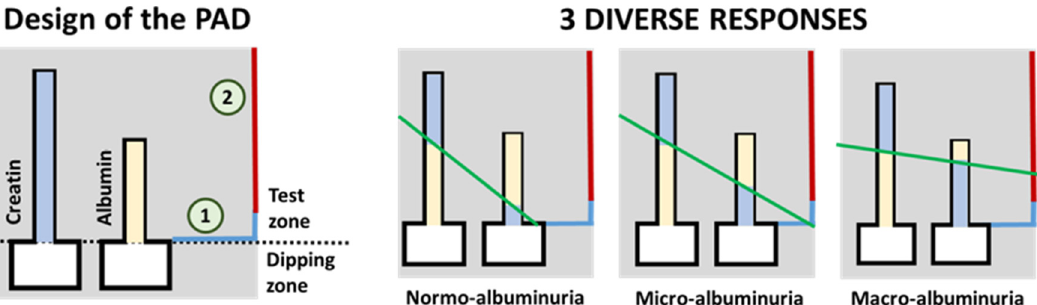
Figure 3. On the left, schematic representation of the paper-based sensor described in Hiraoka et al. [92] for the clinical assessment of albumin index (redrawn). On the right, three possible results for the test are shown. The green line represents a hand-drawn straight line that passes through the top of the two color-changed zones. Results (albuminuria index) are interpreted depending on which zone of the results chart (signaled as 1 or 2 in the scheme on the left) the drawn straight line crosses. For a better interpretation of the color references in this figure, the reader is referred to the web version of the